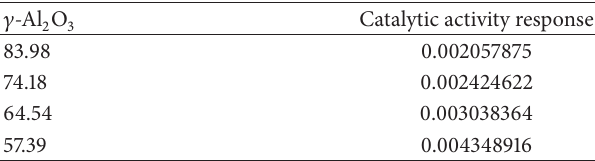
Table 6: Effect of 𝛾 -Al 2 O 3 .